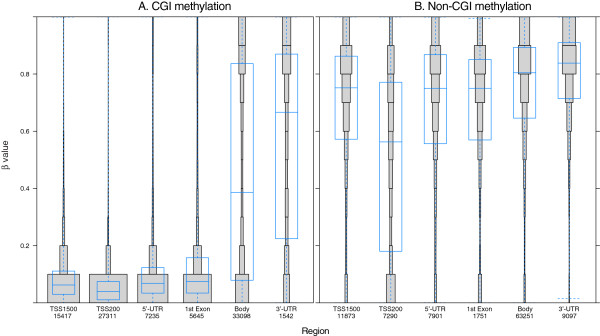
DNA methylation distribution in CGI and non-CGI regions. Distribution of DNA methylation in specific gene regions is shown. Each gene region is further divided into bins that correspond to beta values with 0.1 intervals. The area of each bin corresponds to total number of CpGs. The overall distribution and the mean of beta value of the CpGs in each gene region are shown as a box plot. (A) DNA methylation is low in promoter areas, but high in non-CGI regions of all gene areas (B). (A-B) The numbers on the x-axis correspond to total number of CpGs in each gene region; also the x-axis shows different genomic regions, and the y-axis shows the beta values.